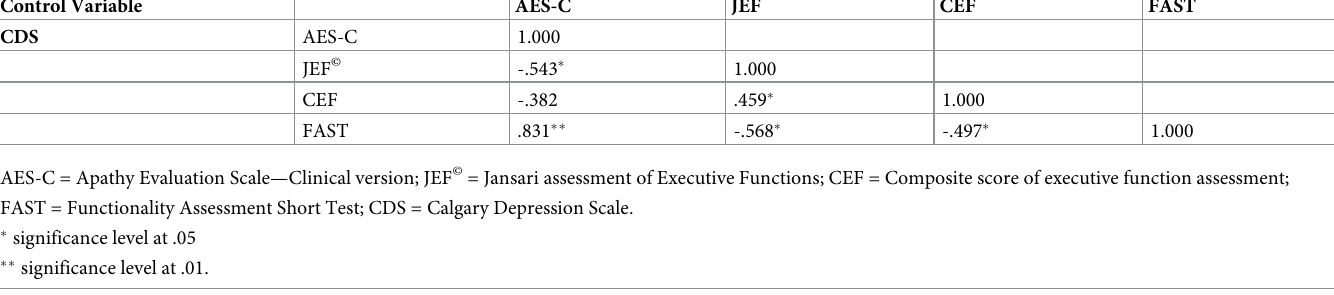
results of the mediation analysis are shown in Fig 1 and Table 4. The univariate regression analysis revealed significant associations between cognition and apathy (X ! M) and between apathy and functional outcome (M ! Y). However, apathy did not show a mediating effect between cognition and functional outcome. Table 3. Partial correlations between apathy, cognition and functional outcome when controlling for depression. Control